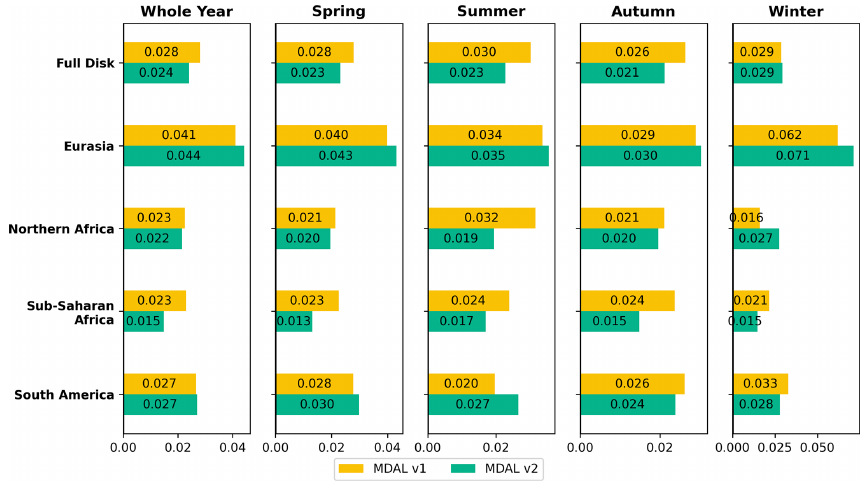
Figure A5. Mean MAE with regard to ETAL by region and season (AL-BB-DH; season names referring to season months of the Northern Hemisphere; spring: MAM; summer: JJA; autumn: SON; winter: DJF).